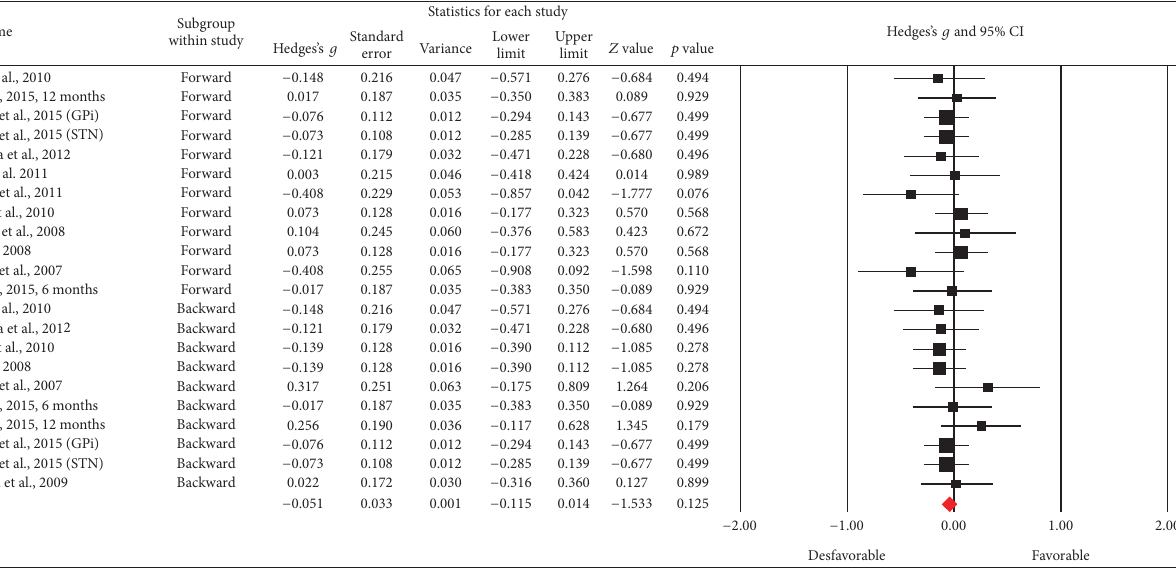
Figure 15: Meta-analysis of DST comparing before and after DBS surgery.